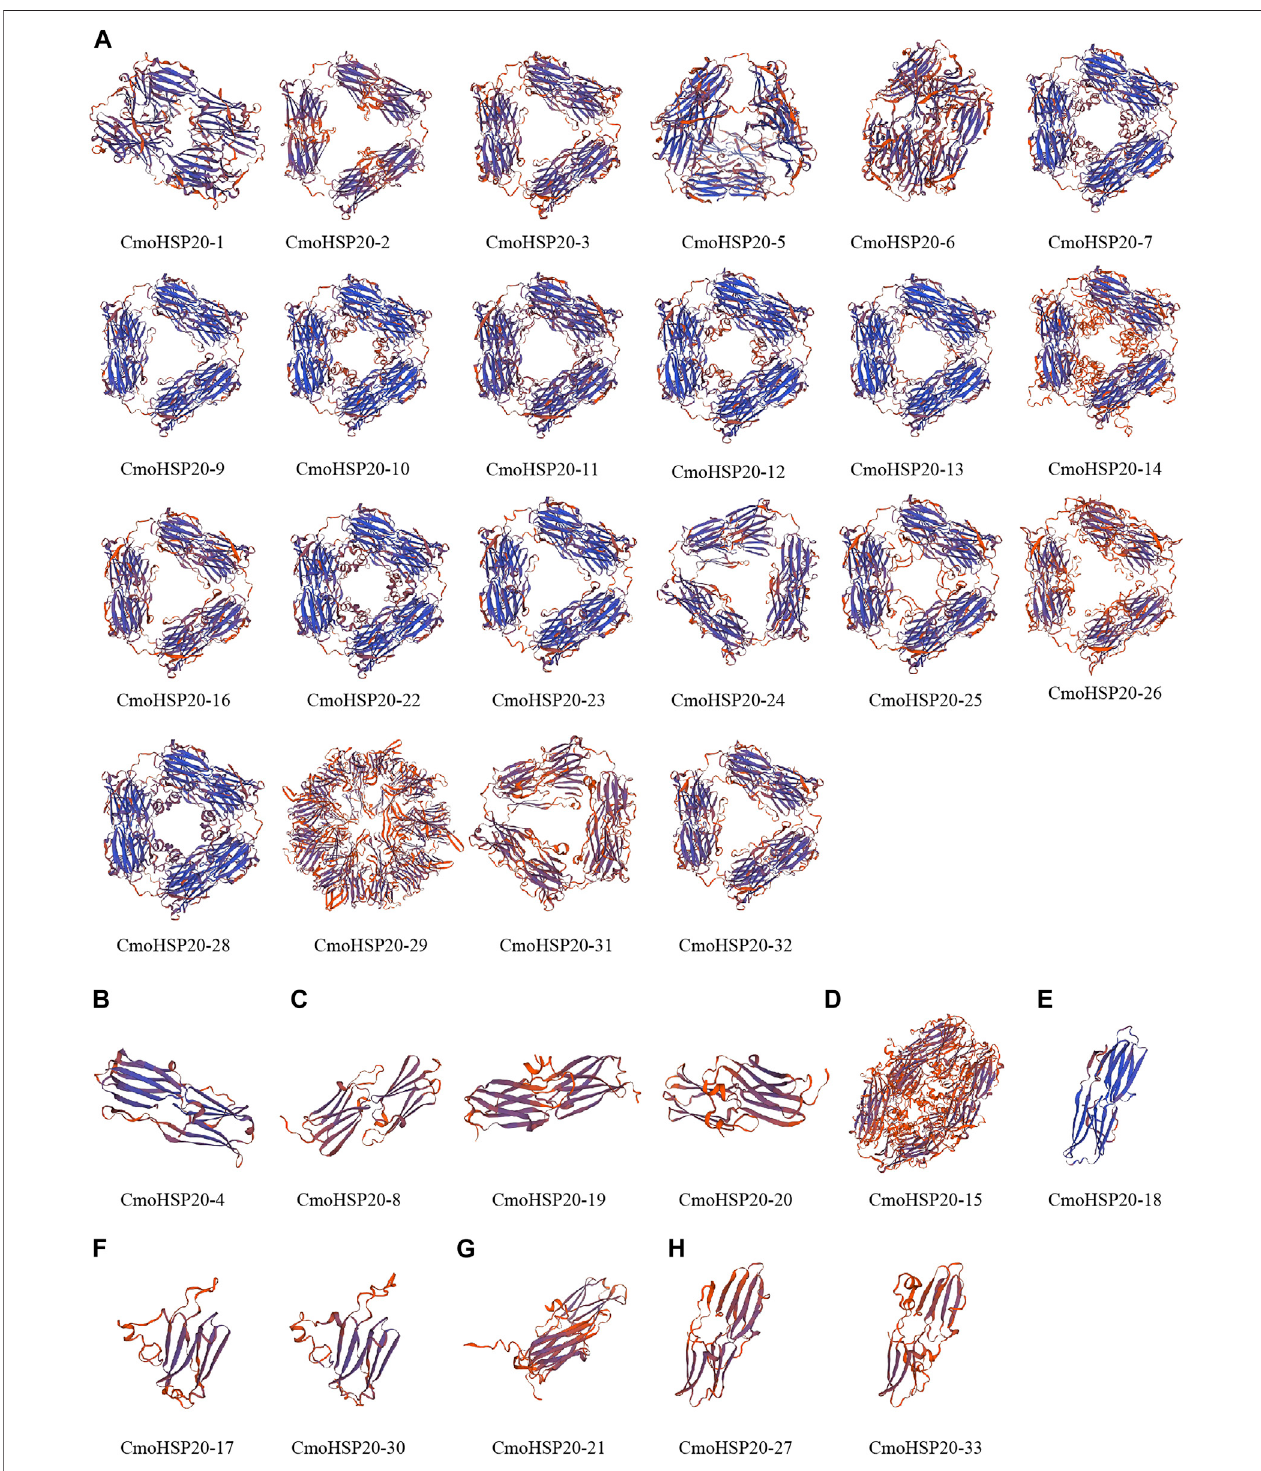
FIGURE 4 | The cartoon representation of the predicted 3-dimensional structural models of CmoHSP20 proteins. The capital letter (A to H) represents the different types.